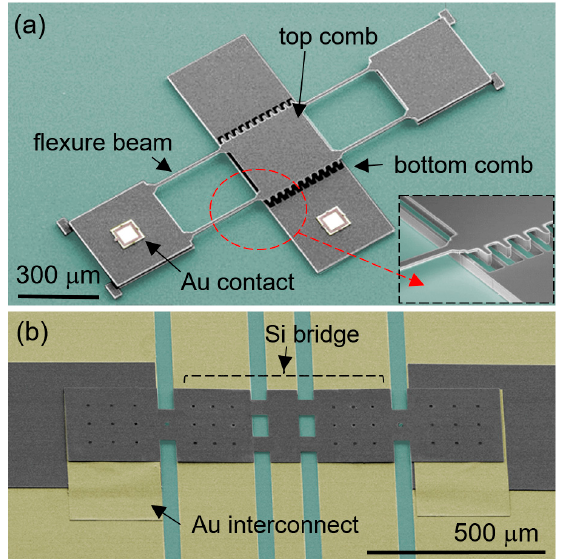
Figure 10. Colored SEM images of ( a ) a microelectromechanical systems (MEMS) vertical comb drive and ( b ) an RF MEMS switch assembled with Si (grey) and Au (yellow) parts on SiO 2 (green) surfaces. Reproduced with permission from [35,79].